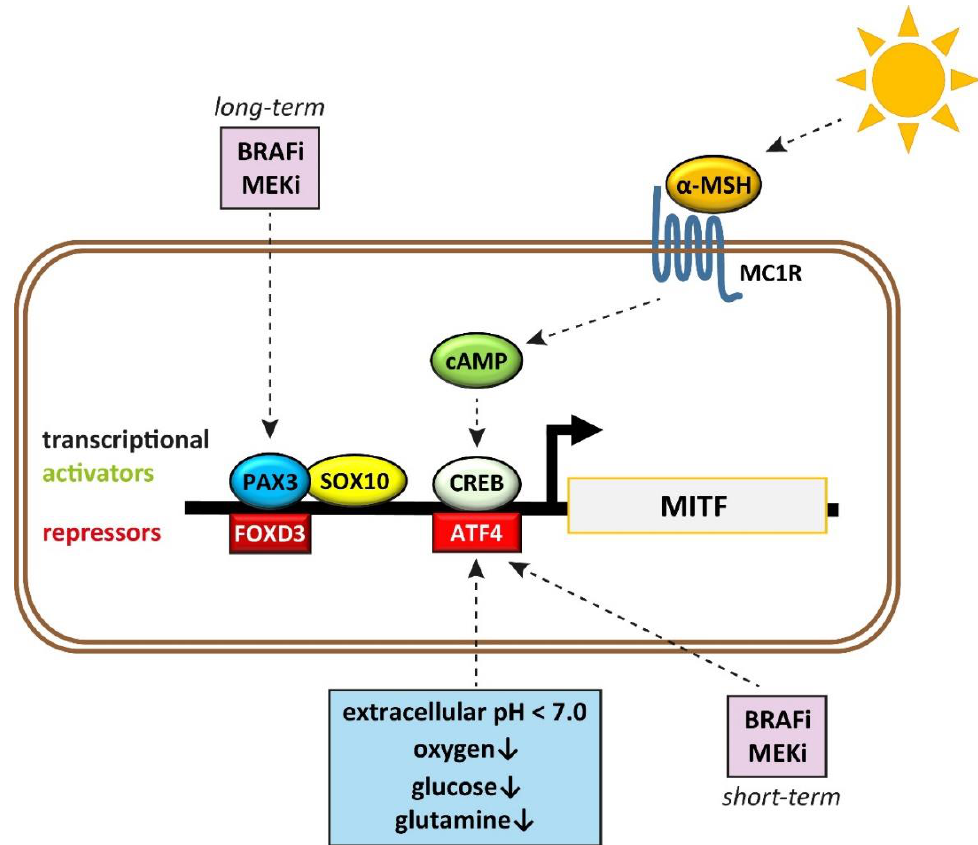
Figure 3. Transcriptional regulators of MITF in melanocytes and melanoma. MITF expression is induced by SOX10, PAX3, and CREB. UV radiation induces α -MSH expression, which binds to its receptor MC1R. This leads to an increase of cAMP and subsequently activates CREB. In contrast, low levels of oxygen, a lack of nutrients, and an acidic extracellular pH can decrease MITF transcription via ATF4 that acts as a transcriptional repressor. BRAF and MEK inhibition (BRAFi, MEKi) can either repress or stimulate MITF expression depending on the treatment duration.